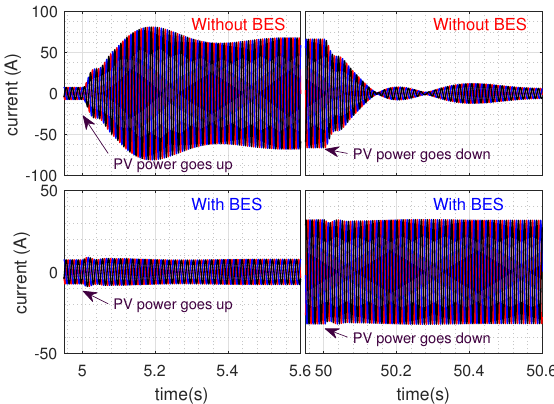
Figure 16. Inverter’s ac current due to the abrupt PV disturbances.